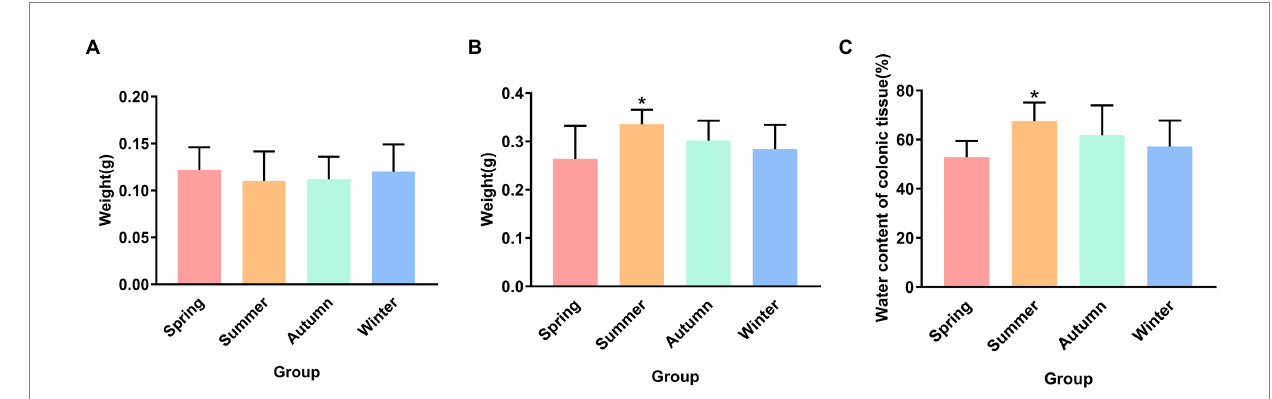
FIGURE 2 . (A) Dry weight of colonic tissue. (B) Wet weight of colonic tissue. (C) Water content of colonic tissue. * p < 0.05 compared with the spring group.